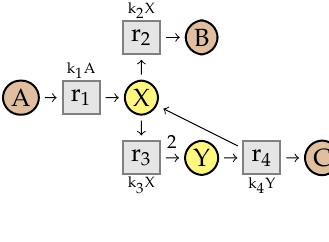
Figure 20. Example illustrating the need of Condition 4.